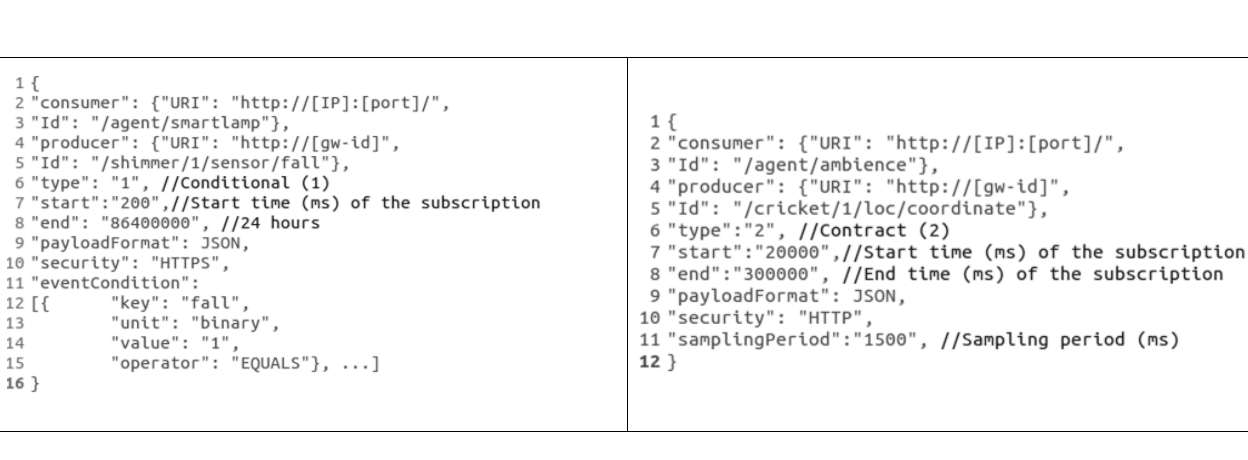
Figure 3. Two subscriptions managed by the Event Management Subsystem. On the